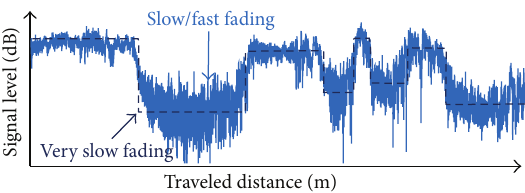
Figure 1: The received satellite signal is characterized by a superpo- sition of very slow, slow, and fast fading